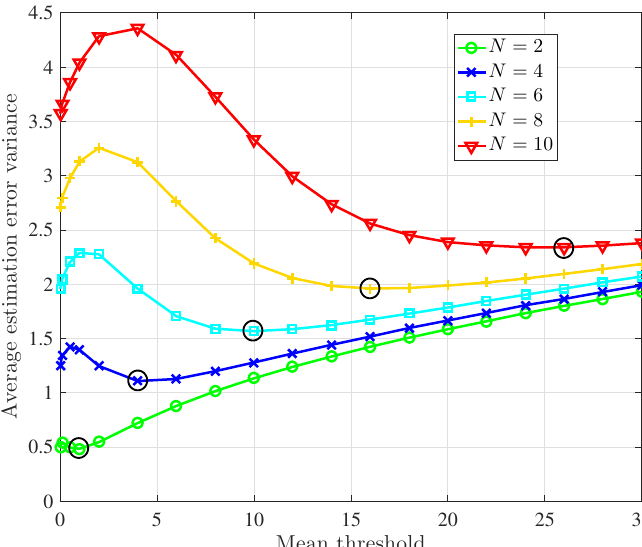
Figure 3. Average estimation error variance vs. the mean threshold under ET and highest AoI scheduling for different numbers of sub-systems N